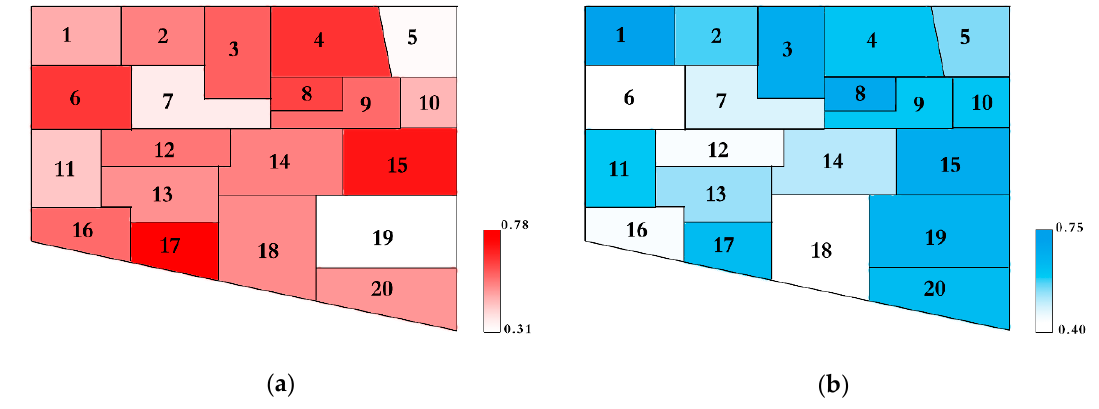
Figure 8. The comprehensive scores of commonality indexes in various regions. ( a ) The scores of WG in various regions; ( b ) The scores of electric vehicle (EV) in various regions.